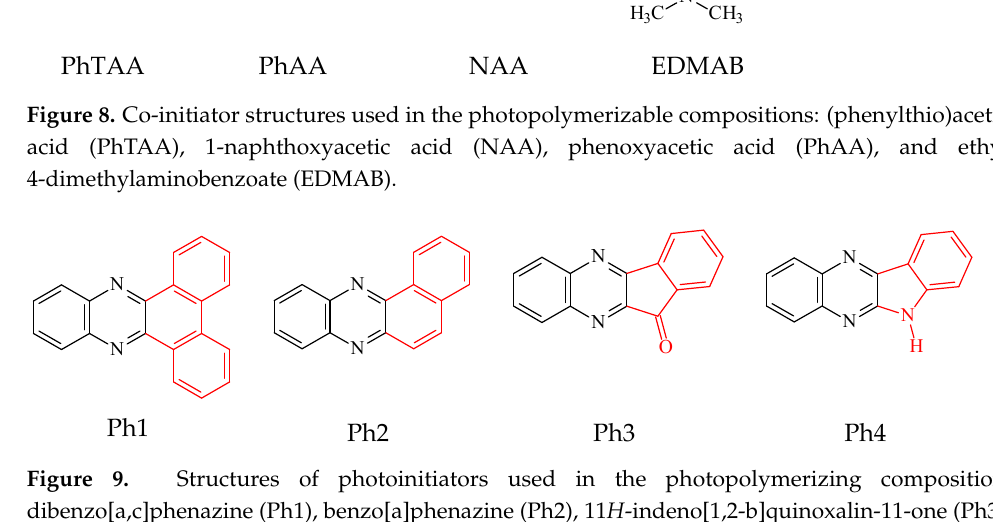
Figure 9. Structures of photoinitiators used in the photopolymerizing composition; dibenzo[a,c]phenazine (Ph1), benzo[a]phenazine (Ph2), 11 H -indeno[1,2-b]quinoxalin-11-one (Ph3), and 6 H -indolo[2,3-b]quinoxaline (Ph4). Table 1. Photoinitiator concentration in the tested polymer composite: dibenzo[a,c]phenazine (Ph1), benzo[a]phenazine (Ph2), 11 H -indeno[1,2-b]quinoxalin-11-one (Ph3), 6 H -indolo[2,3-b]quinoxaline (Ph4) and camphorquinone (CQ).